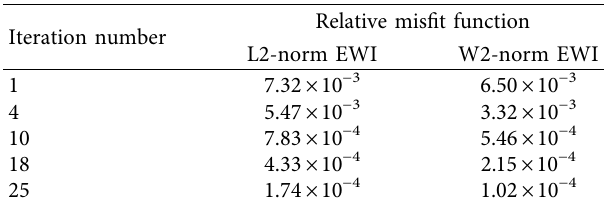
Figure 10: The normalized waveform misfit of L2-norm EWI and W2-norm EWI results. Table 1: The applications in field data: relative misfit function of L2- and W2-norm EWI,